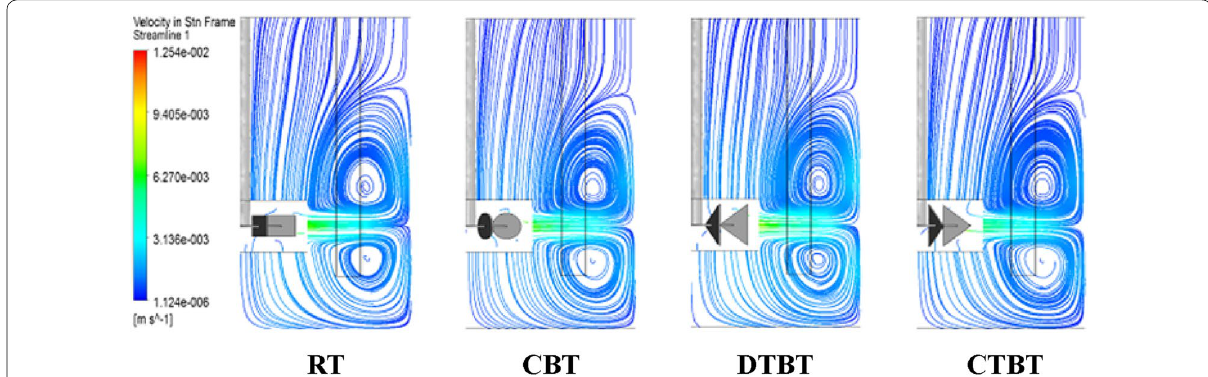
Figure 9 Stream lines for agitator’s types with L / H